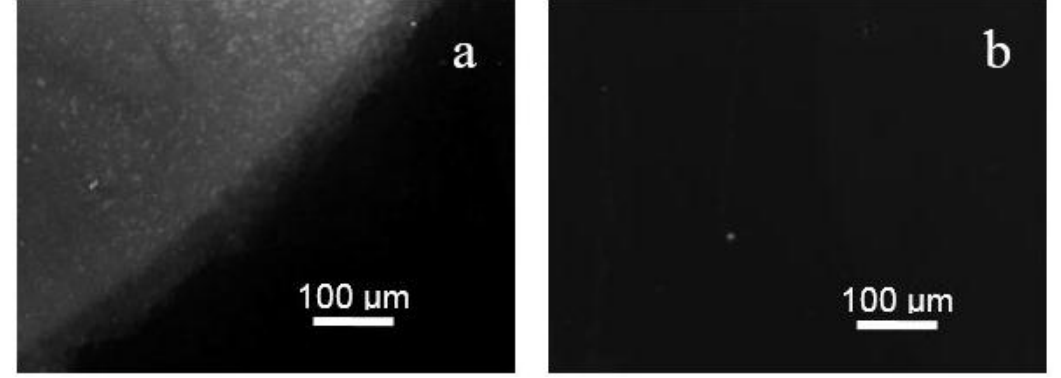
Figure 2. Typical epifluorescence micrographs showing the border of DNA drop on 380-nm-thick SnO 2 nanoporous films after hybridization with Cy3 labelled targets in the case of ( a ) complementary and ( b ) non-complementary DNA hybridization with target concentration of 2